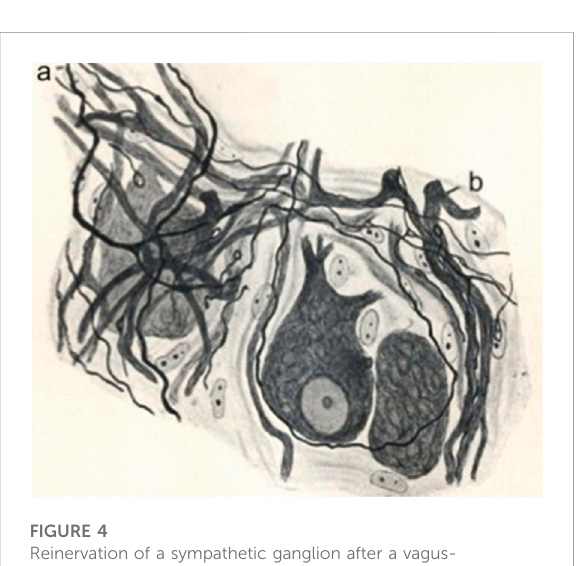
FIGURE 4 Reinervation of a sympathetic ganglion after a vagus- sympathetic crossed anastomosis. Regenerated preganglionic fi bers invade the ganglion. Adapted from de Castro, 1937; reproduced in de Castro, 2016.